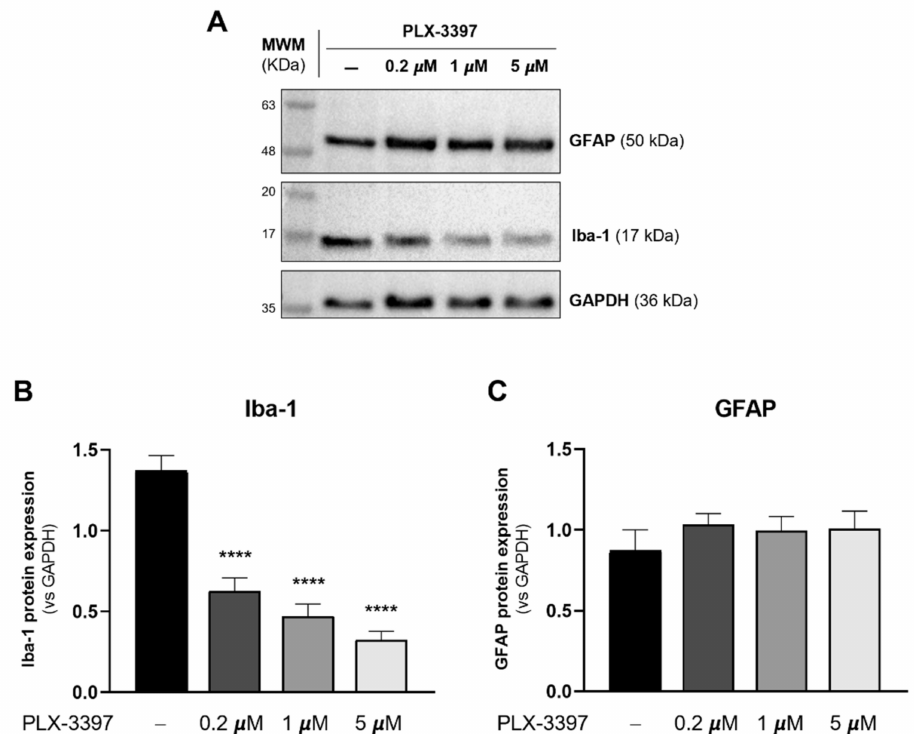
Figure 2. PLX-3397 decreases Iba-1 expression, but has no impact on GFAP expression, in primary cultures of astrocytes. ( A ) Representative immunoblots of GFAP, Iba-1 and GAPDH with no exposure ( − ) and exposure to 0.2 µ m, 1 µ m and 5 µ M PLX-3397. Densitometric analysis of ( B ) Iba-1 and ( C ) GFAP was performed with ImageJ software using GAPDH as loading control. All values are mean ± SEM. N = 4 independent experiments. Statistical analysis was performed with one-way ANOVA followed by Dunnett’s multiple comparison test, **** p < 0.0001, in comparison with control